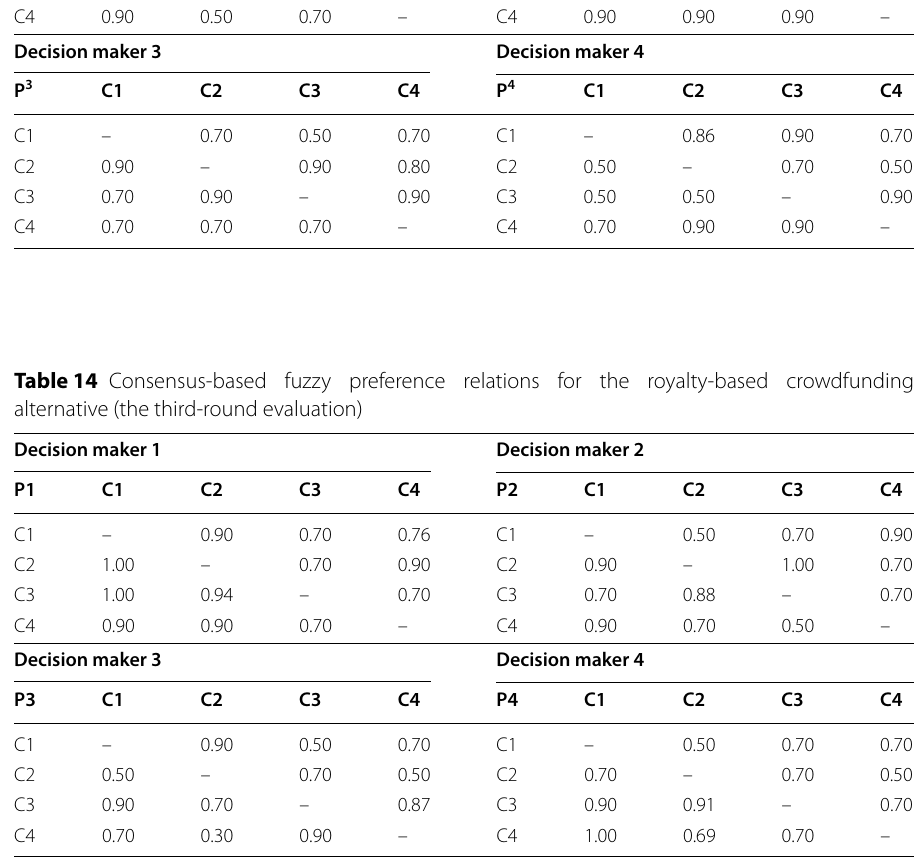
Table 13 Consensus-based fuzzy preference relations for the debt-based crowdfunding alternative (the second-round evaluation) Decision maker 1